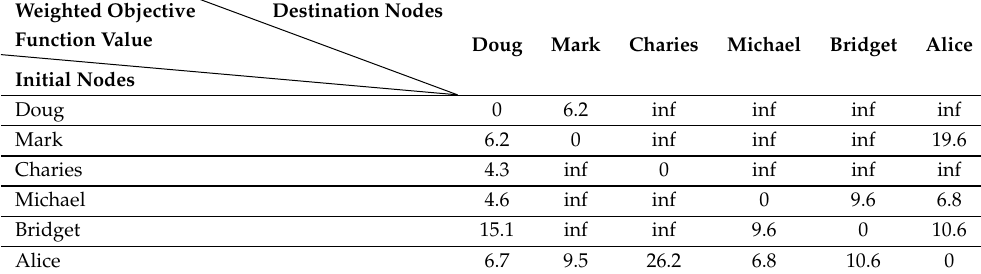
Table 3. The weighted objective function value between user nodes in the